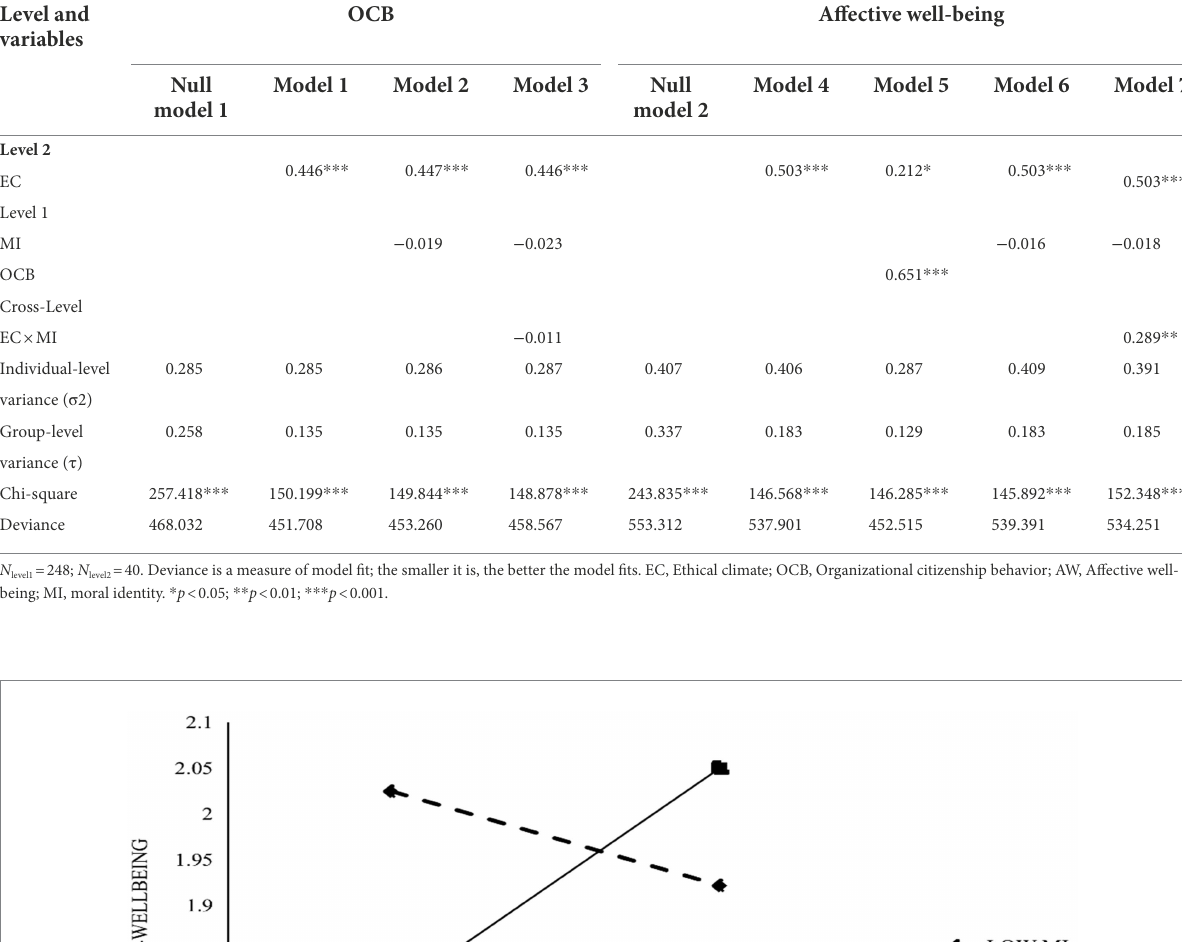
TABLE 3 Regression analysis for hypothesis: model summary.